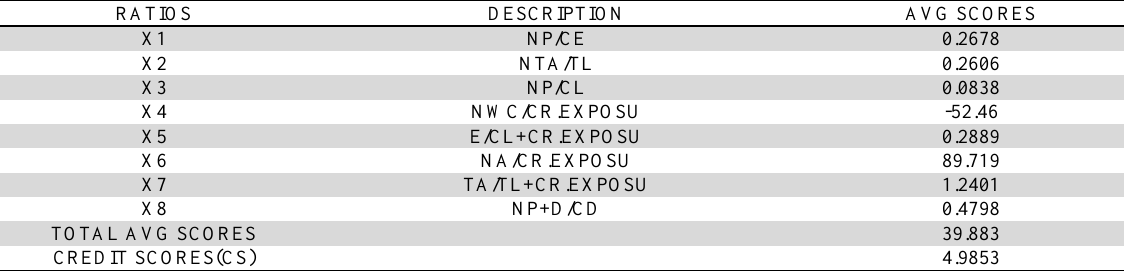
Risk Description Model – Ratio